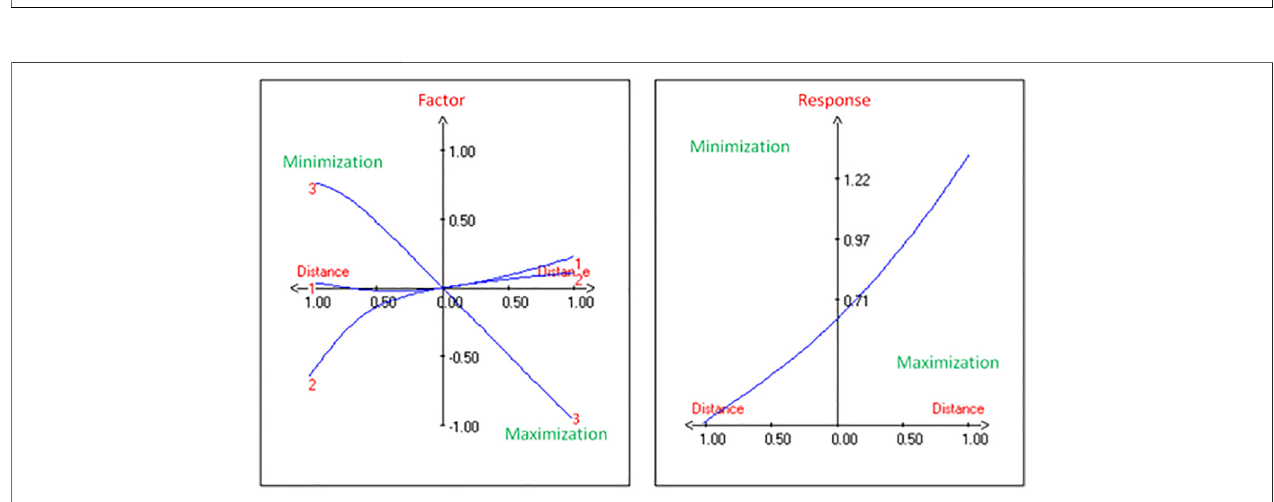
FIGURE 3 | Determination of maximum PHA yield from H. desertis G11 through optimum schemes generated by NemrodW software.